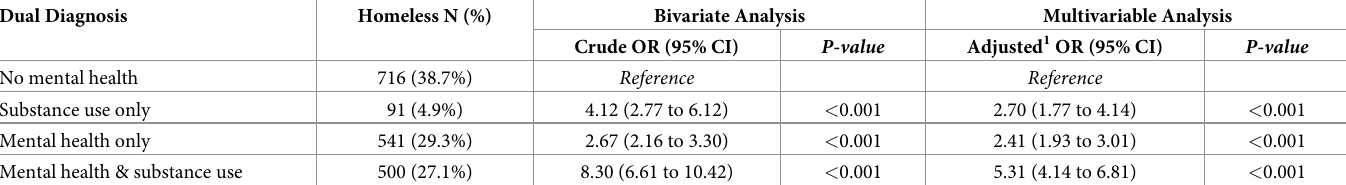
Table 5. Ordered logistic regression analysis for dual diagnosis mental health and substance use predictors of homelessness